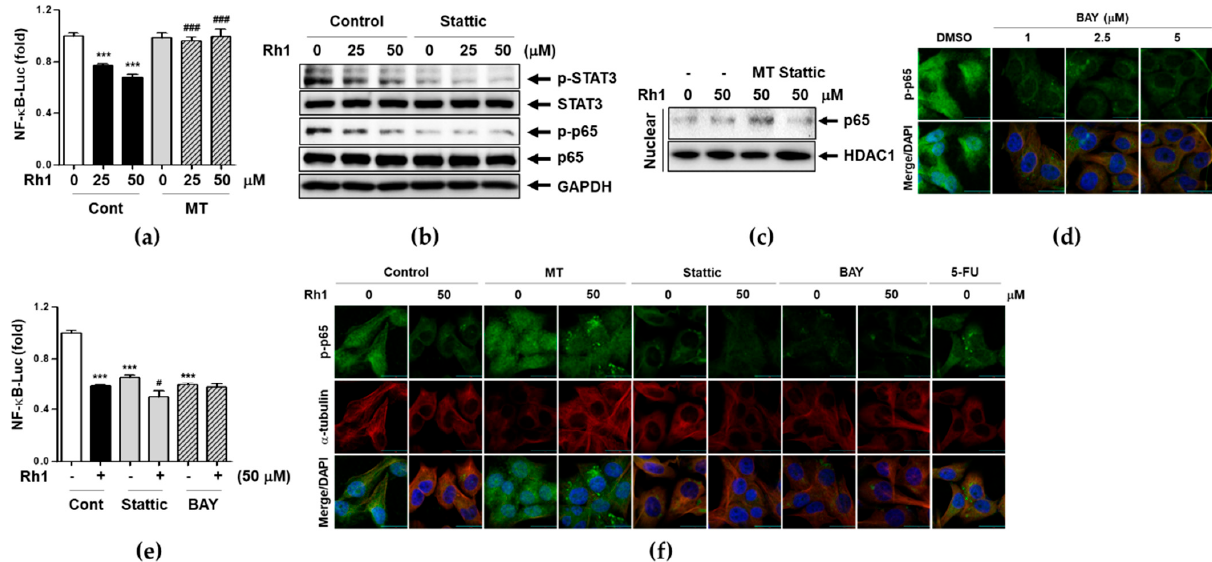
Figure 6. Rh1 inhibits transcriptional activity of NF- κ B through STAT3 inactivation via production of mtROS. ( a ) MDA-MB-231 cells were co-transfected with pNF- κ B-Luc and Renilla-Luc for 18 h. After transfection, cells were pretreated with 5 µ M MT for 1 h followed by treatment with 25 and 50 µ M Rh1. NF- κ B-Luc promoter activity was measured using dual-luciferase reporter assay. Relative NF- κ B-Luc promoter activity was determined and normalized by Renilla luciferase activity. ( b ) MDA-MB-231 cells were pretreated with 1 µ M stattic for 1 h followed by treatment with 25 and 50 µ M of